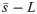
Expression of Nintra in clones of cells leads to smooth clone borders but no change in cell bond tension at the clone border.(A,B) Wing discs of wandering stage third instar larvae displaying control clones (A) or clones expressing Nintra (B, Act5C>Gal4, UAS-Nintra) marked by the expression of CD8-mCherry (red) and stained for E-cadherin (green). Scale bars: 30 μm. (C,D) Magnification of the inset in (A,B). Scale bars: 10 μm. (E,F) Segmentation of the images shown in (C) and (D). The clones are marked in blue. (G) Scheme depicting the measurement of clonal roughness. The shape of a clone is described by a sequence of the position of the vertices along the clone border Ri = (Xi,Yi). For any two vertices i and j at the clone border, s is the contour length along the clone border and L is their point-to-point segment length. For any indicated segment length L, clonal roughness measures the average of deviation of contour length from a straight line, s¯−L. (H) Clonal roughness for control clones and clones expressing Nintra. Segment length and clonal roughness values are normalized by the average cell bond length in the tissue l¯ = 1.7 μm. Mean and s.e.m. are shown (control, n = 9 wing discs; mutant, n = 8 wing discs), P <0.001–0.05 for L = 2–10. (I) Change in distance d between the vertices at borders of control clones or of clones expressing Nintra or of vertices inside clones expressing Nintra after ablation (normalized to l¯) as a function of time. Mean and s.e.m. are shown (control, n = 9; Nintra, n = 9; inside Nintra, n = 6 cuts). (J) Initial velocity of vertex displacement after ablation of cell bonds indicated in (I). Mean and s.e.m. are shown (n as in I). n.s. not significant.